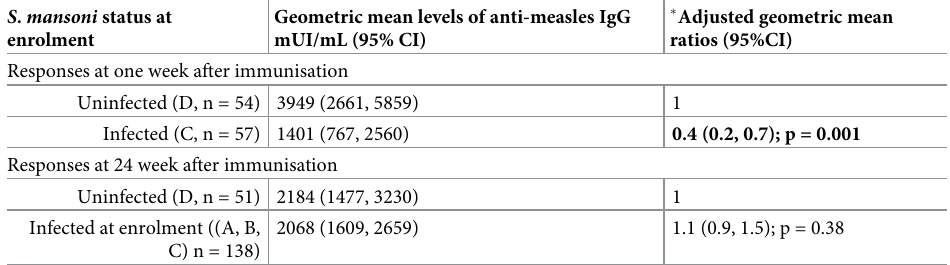
Table 3. Association of S mansoni infection with antibody levels one and 24 weeks following measles catch-up immunisation.